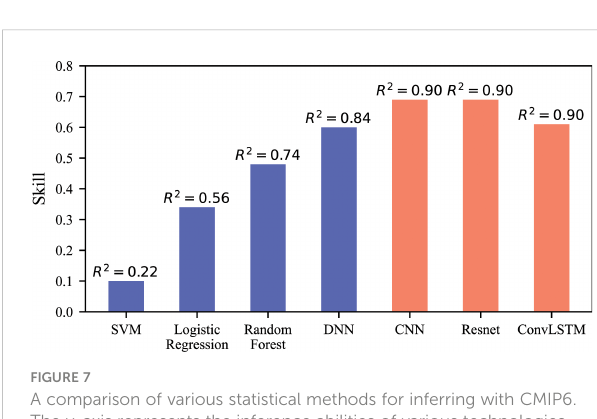
FIGURE 7 A comparison of various statistical methods for inferring with CMIP6. The y-axis represents the inference abilities of various technologies, such as SVM, logistic regression, random forest, DNN, CNN, ResNet, and convolutional LSTM network. The R 2 of each column represents the proportion of inferred variance.